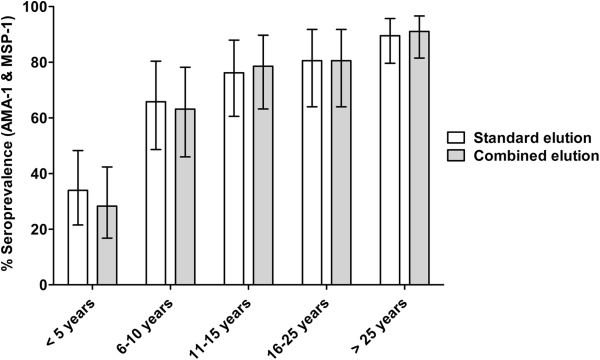
Seroprevalence of anti-AMA-1 or MSP-142 IgG responses by filter paper elution method and age. Error bars indicate 95% confidence intervals (CI). Sample sizes for the age groups were 53 (< 5 years), 38 (6–10 years), 43 (11–15 years), 36 (16–25 years), and 67 (>25 years).